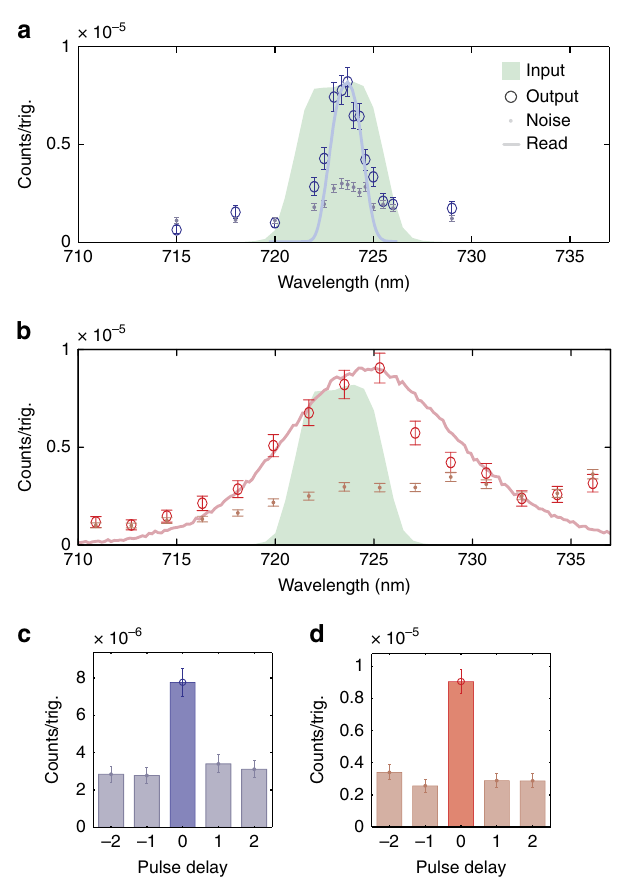
Figure 4 | Bandwidth conversion. ( a ) Narrowed output spectrum (hollow circles) and noise (dots) with read beam FWHM at 2.1nm. ( b ) Expanded output photon spectrum (hollow circles) and noise (dots) with read beam FWHM at 12.1nm. ( a , b ) Corresponding read beam spectra, blue-shifted by the phonon frequency, are shown (solid lines) for reference along with the input photon spectrum (green). ( c ) Coincidence detection events between bandwidth narrowed output photons, and ( d ) expanded output photons and heralds while scanning the electronic delay between them, as measured at the peak of the spectrum. ( a – d ) Error bars show 1 standard deviation calculated assuming Poissonian